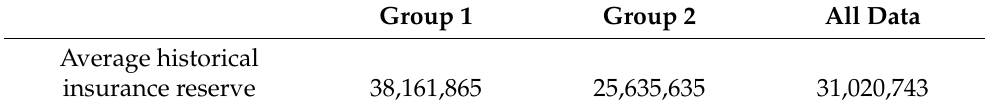
Table 9. Result of Insurance reserve comparison between period in each Groups.